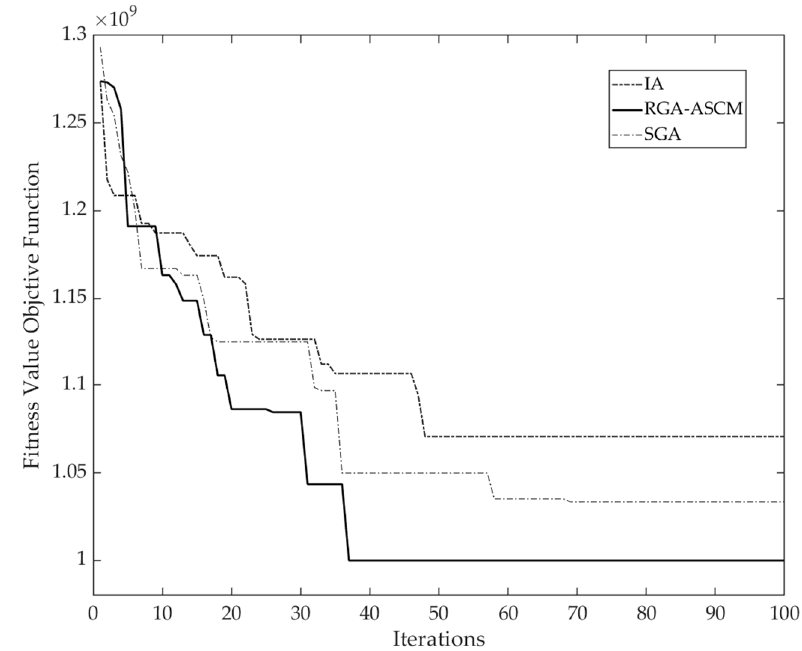
Figure 26. Convergence diagram comparison in 100 generations (iterations) for Case 3.